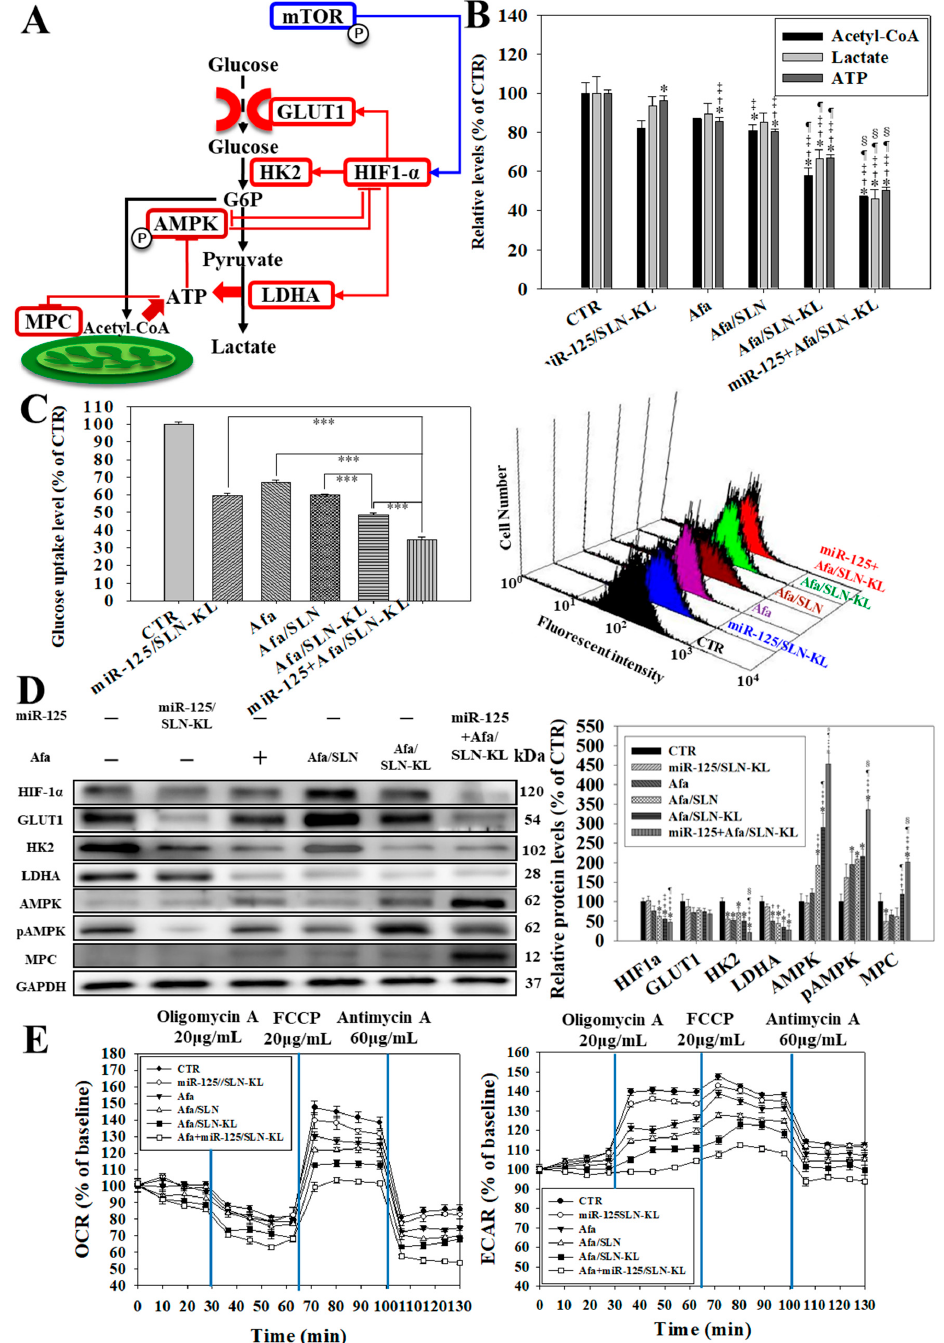
Figure 4. Effects of miR-125 (100 nM)- and/or Afa (300 nM)-loaded formulations on glycolysis pathway-related factors in AGS cells after 24 h treatment. ( A ) Scheme of glycolysis pathway. ( B ) Mea- surement of relative levels of acetyl-CoA, lactate, and ATP by using a multifunctional microplate reader. ( C ) ( Left ) Measurement of glucose uptake by detecting fluorescent analog of glucose (2-NBDG, 2-deoxy-2-[(7-nitro-2,1,3-benzoxadiazol-4-yl)amino]-D-glucose; 20 mM) with the use of a flow cy- tometer (statistical significance at *** p < 0.001). ( Right ) Histogram plots of fluorescent 2-NBDG after various treatments in AGS cells. ( D ) ( Left ) Effect of various formulations on the expression of proteins in glycolysis-related pathway. ( Right ) Quantification of relative protein levels in glycolysis-related pathway. ( B , D ) * p < 0.05: compared with CTR, † p < 0.05 compared with miR-125/SLN-KL, ‡ p < 0.05 compared with Afa, ¶ p < 0.05 compared with Afa/SLN, and § p < 0.05 compared with Afa/SLN-KL via Student’s t -test analysis. ( E ) Measurement of ( left ) oxygen consumption rate (OCR) and ( right ) extracellular acidification rate (ECAR) by using an XFe24